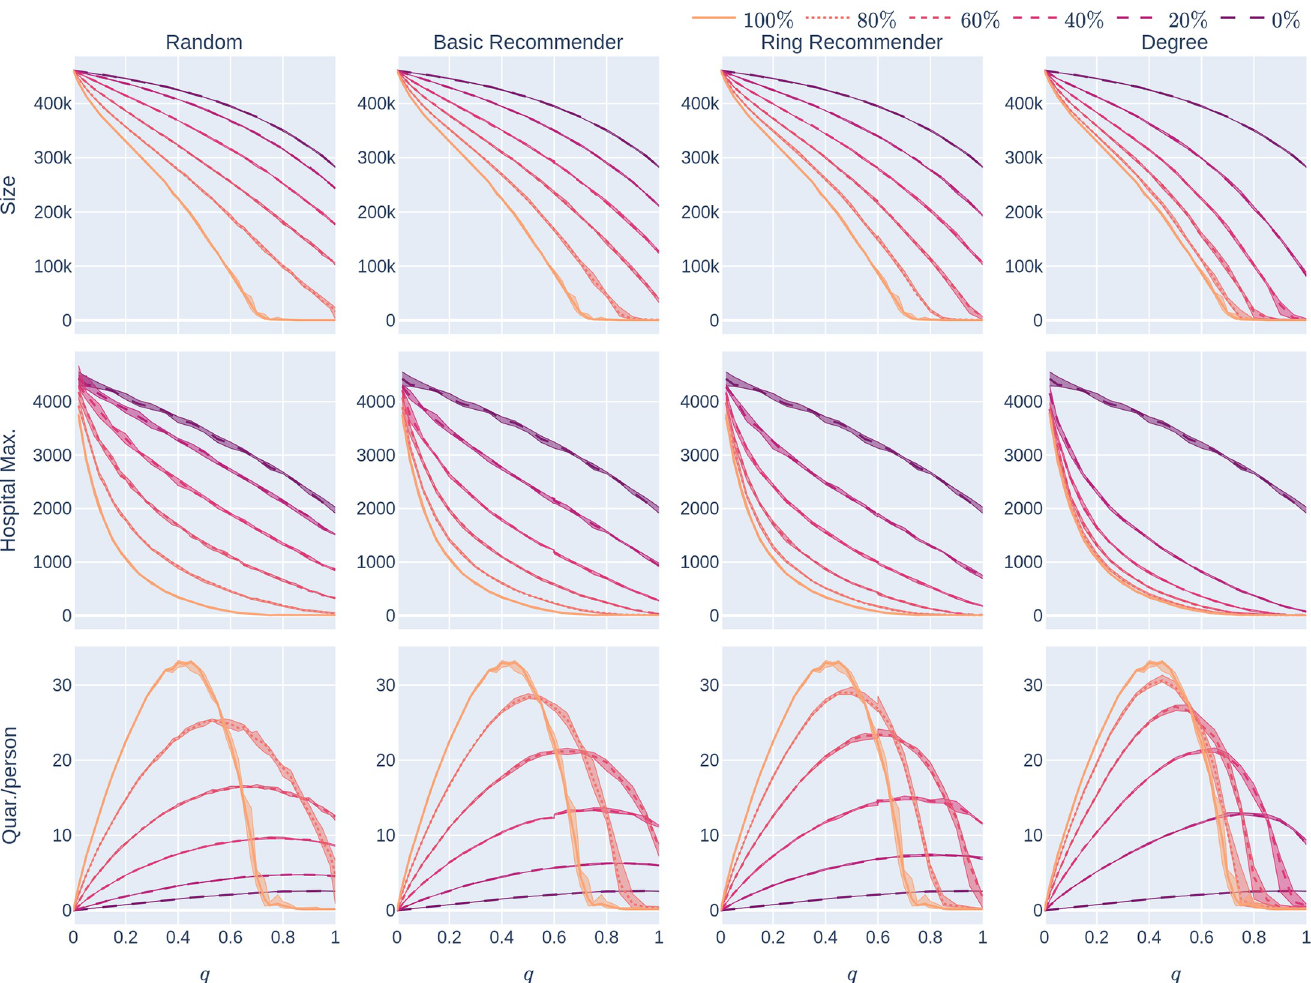
Fig 13. Experiment 2 for a less geometric network: Influence of the quarantine strictness q for various uptake percentages p % and the four uptake scenarios: The KPIs are plotted against q , the quarantine strictness. We work here with a fixed underlying network, a 500,000 node GIRG with τ = 3.3 and α = 1.3. Each column represents a given uptake scenario (random, basic-recommender and ring-recommender, and degree-targetted). The x -axis shows the quarantine strictness q varying from 0 to 1 at step size 0.05. Simulations are done for the 21 values of q corresponding to these steps. There is an additional simulation point at 0.02 (in order to avoid division by 0 in the computation for HMax and still have a point close to 0). The y -axis shows the corresponding value of the KPI. The curves on each figure correspond to the different uptake percentages, as labelled. For each parameter value, the plotted result is the median over 5 runs. The shaded region around the plot covers the results of all 5 simulations. The epidemic is started by infecting 100 individuals, chosen uniformly at random. Simulation is halted when there are no more exposed or infected vertices. The infection rate is β = 0.05.